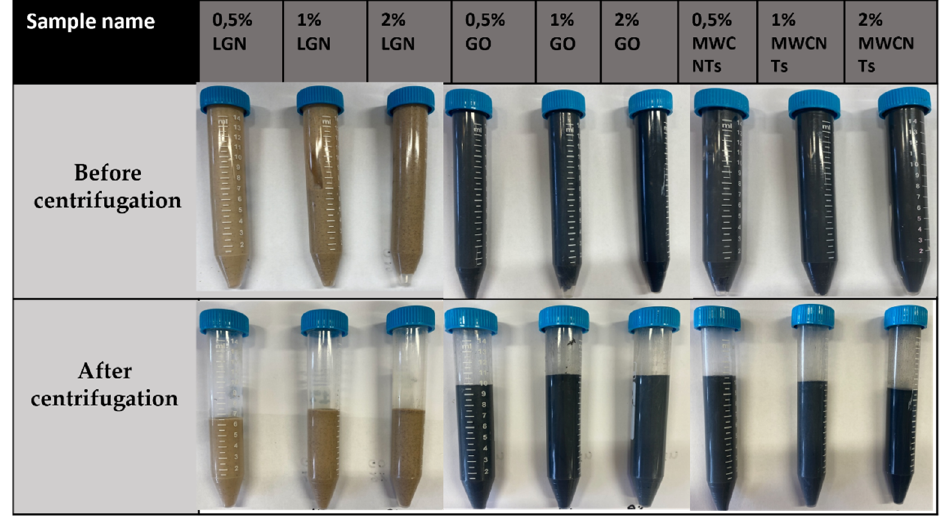
Figure 7. Images of O/W emulsions before and after centrifugation at 4000 RPM, 25 °C for 15 min. No phase separation is witnessed at any of the emulsions.